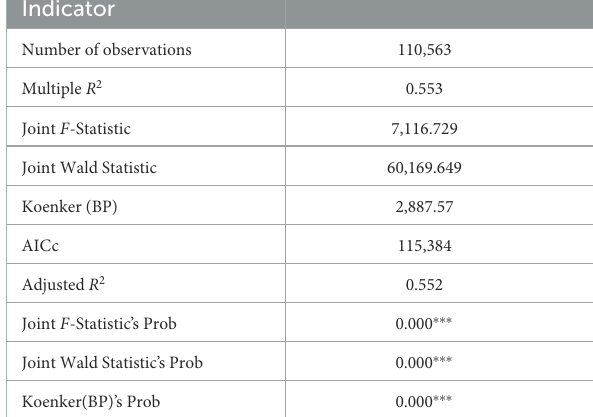
TABLE 4 OLS diagnostics.